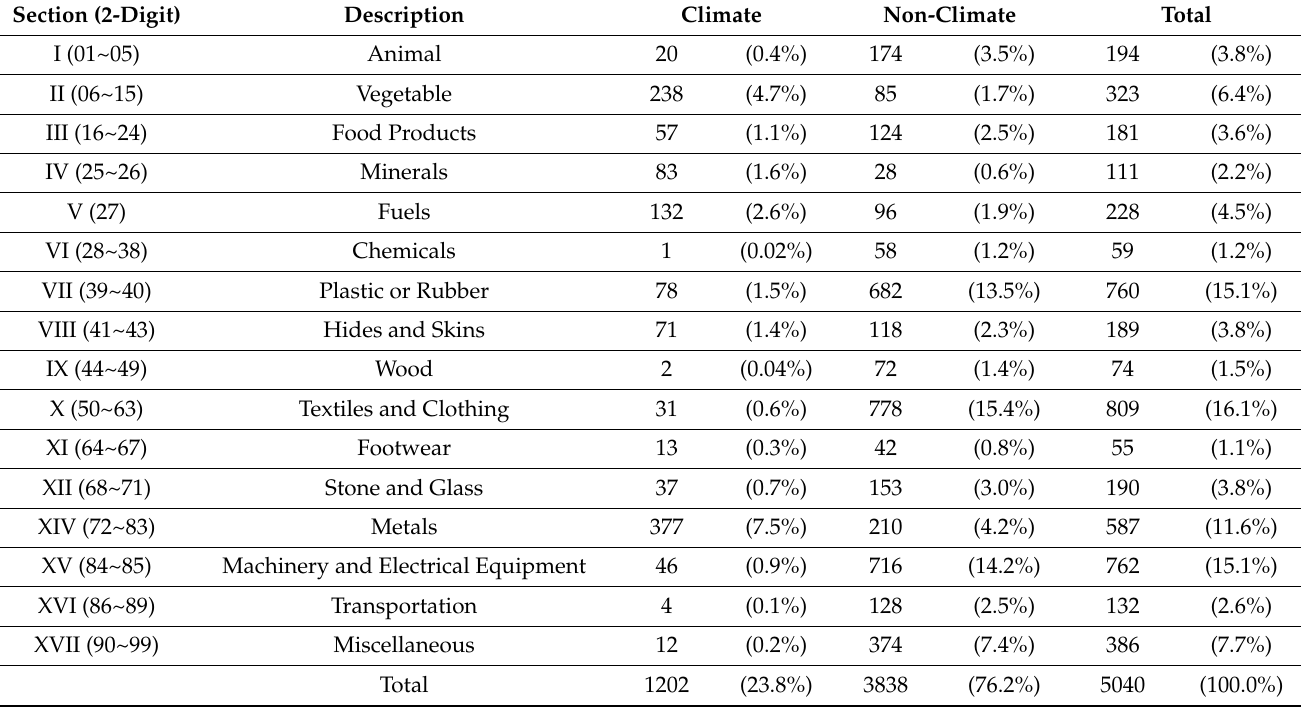
Table 3. Climate Change Classification by